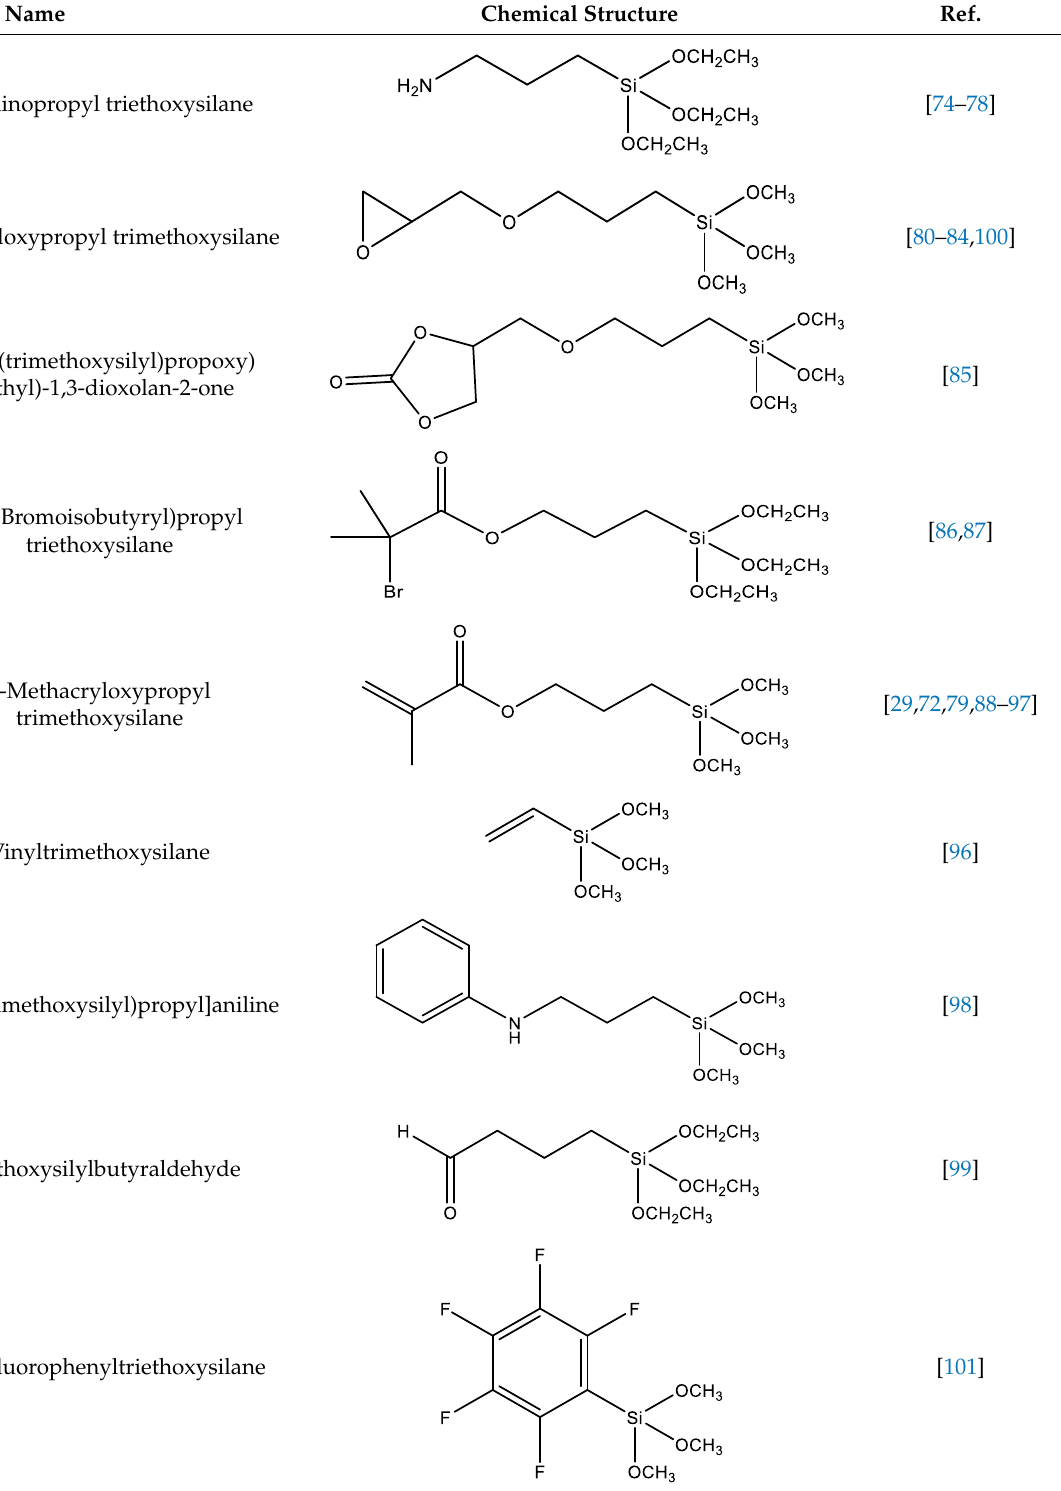
Table 2. Most common coupling agents used in the preparation of hybrid silica-polymer materials.